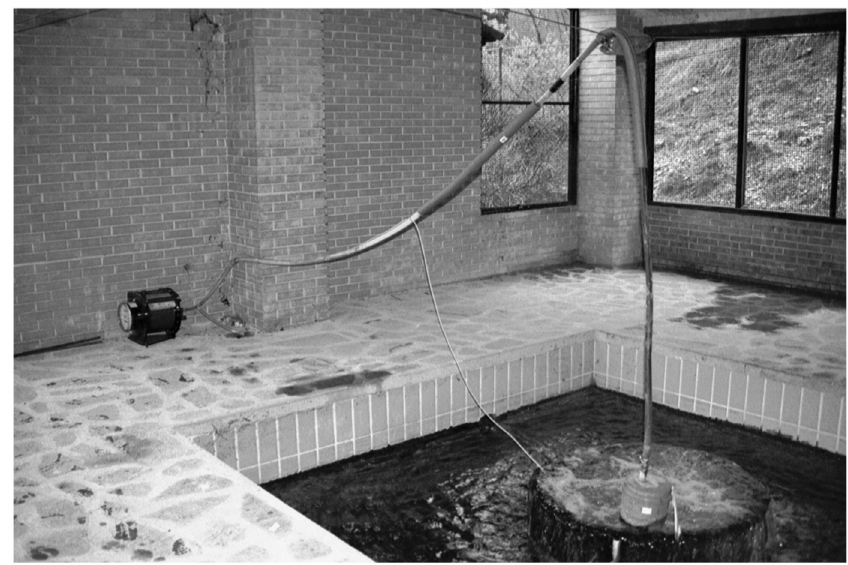
Fig. 4. Station of Tramutola with gas flow meter and the strong gas emission at the thermal-water